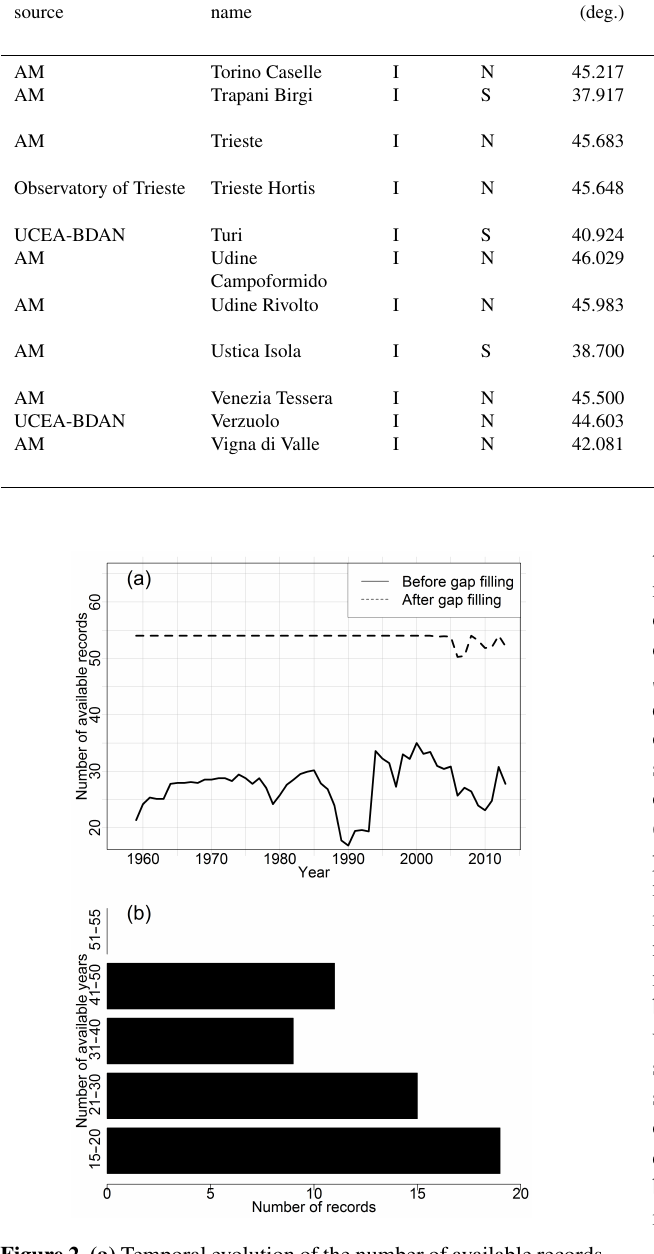
Figure 2. (a) Temporal evolution of the number of available records per year before (bold line) and after the gap-filling procedure (dashed line) (see Sect. 2.2); (b) the histogram shows the number of records as a function of the number of available years before the gap-filling